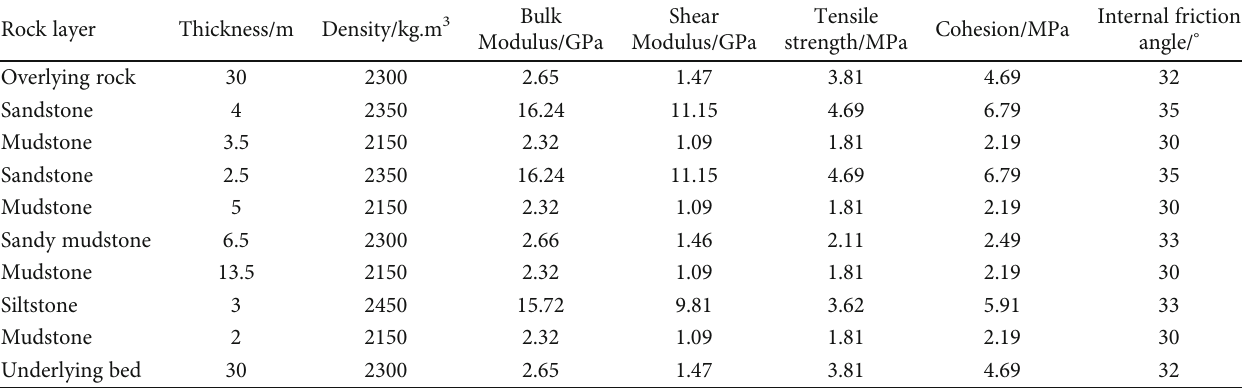
Table 1: The physical parameters of the rock layers.